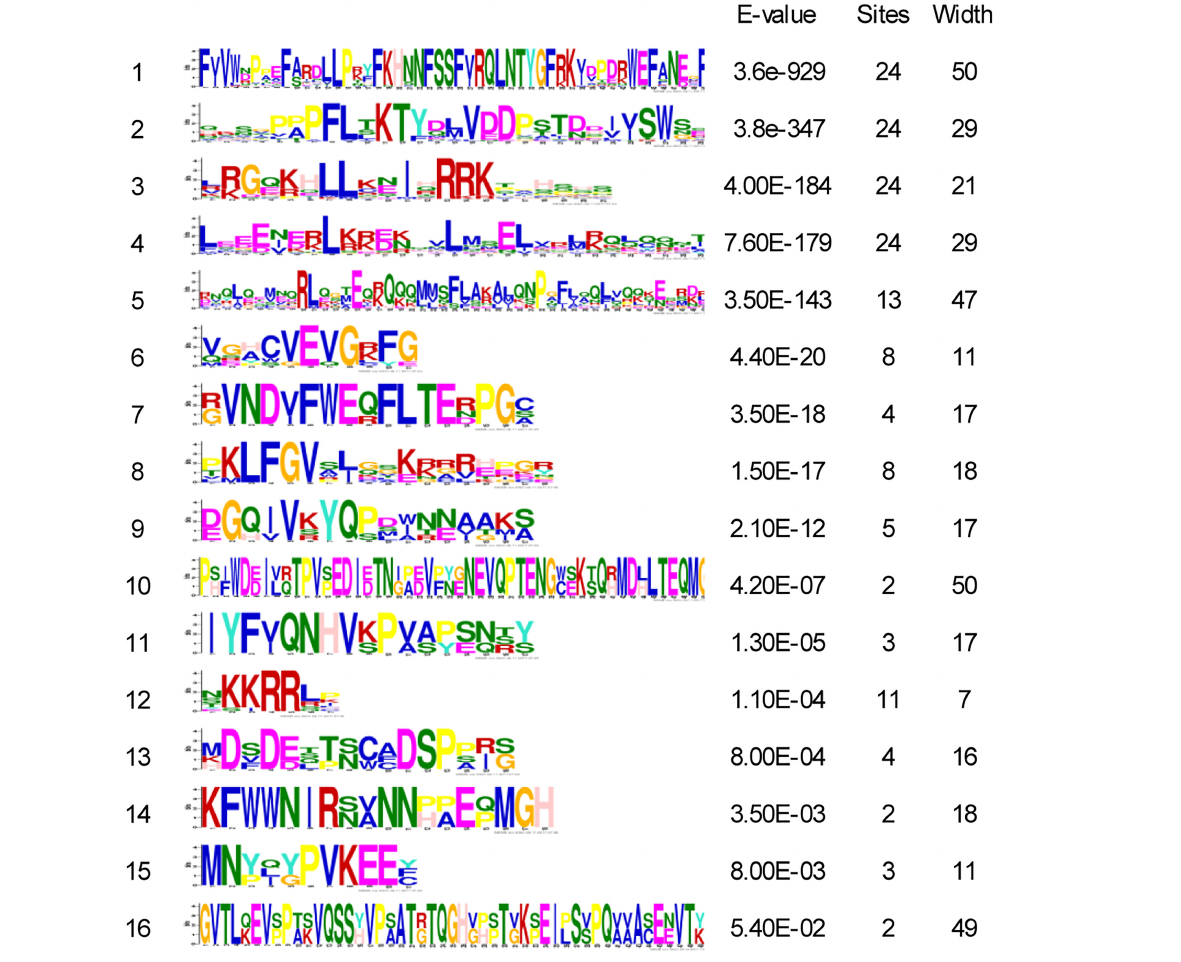
FIGURE 3 | Sequence logos of 16 motifs in VrHsf proteins. The “sites” indicate the number of VrHsf proteins containing each motif. The “width” indicates the amino acid number of each